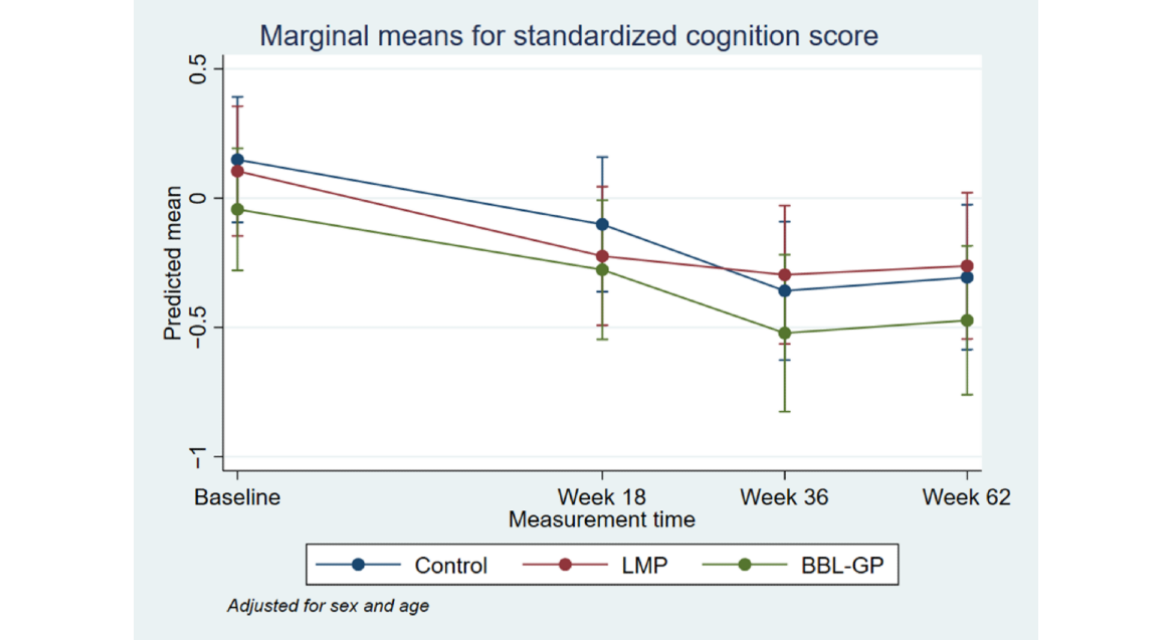
Figure 3. Mean standardized cognition score with 95% CI, by time point and intervention group. BBL-GP: Body Brain Life in General Practice; LMP: Lifestyle Modification